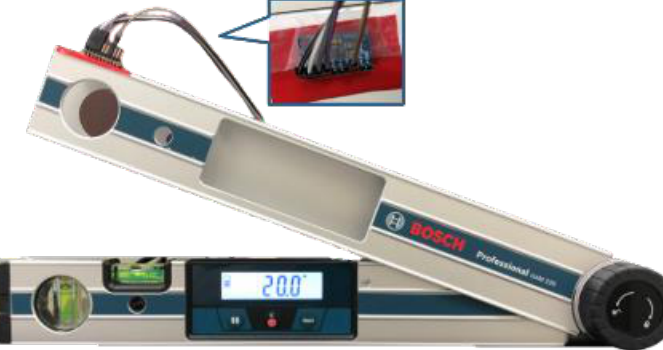
Figure 3. ROMSS verification in static sensing.